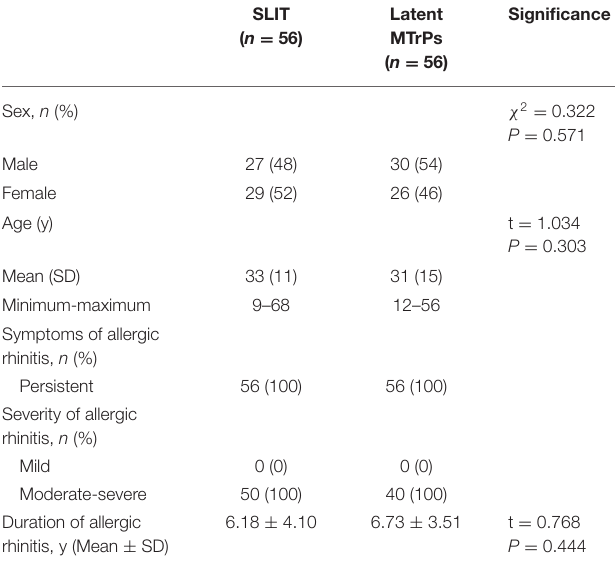
TABLE 1 | Demographic characteristics of included